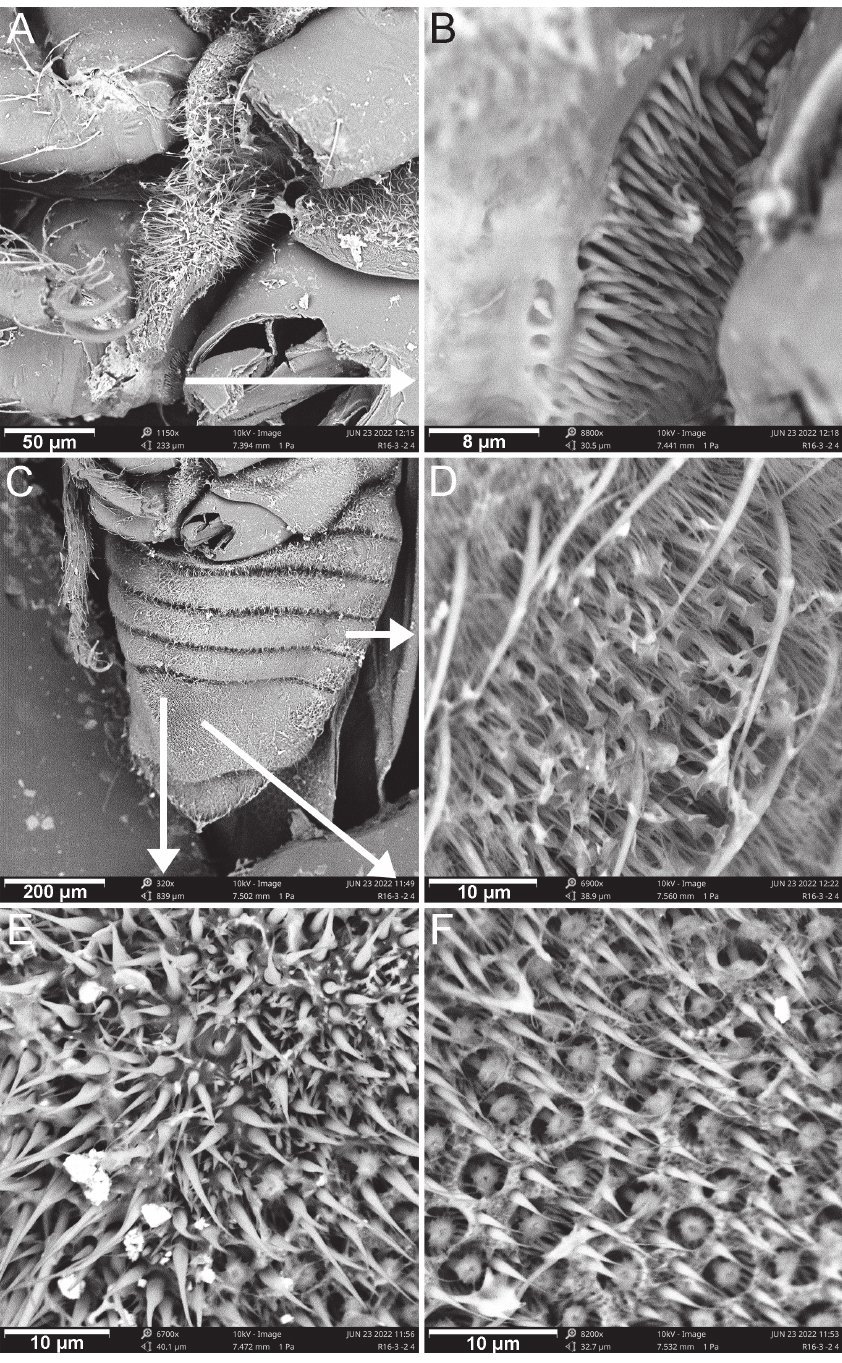
Figure 6. Scanning electron micrographs of Cornonannus bui gen. et sp. nov., male paratype in ventro- lateral view A metasternal spine B adhesive pad C abdomen D microtrichia on area near connexivum E middle region of basal sternite VII F middle region of sternite